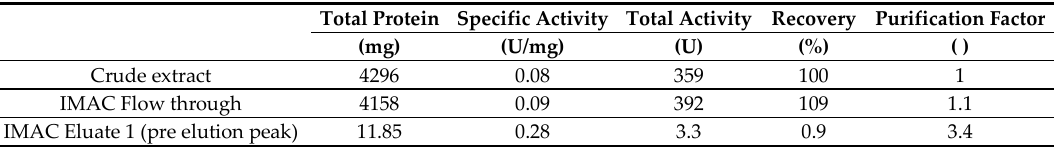
Table 1. Summary of the purification process of Ct XR. Recovery and purification factor are given relative to the activity in the crude extract and, in brackets, for retained fractions relative to the preceding